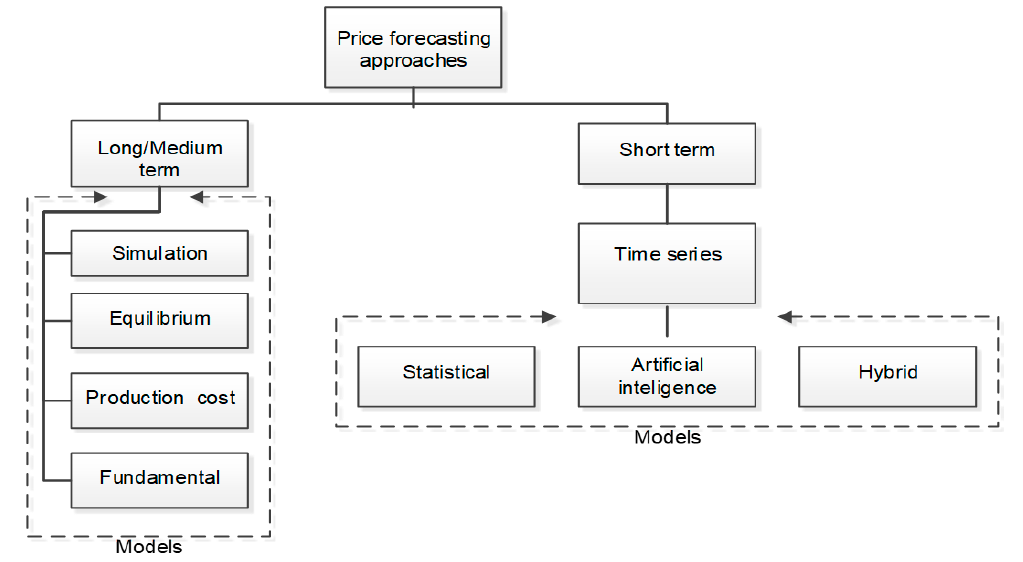
Figure 1. Classification of price forecasting